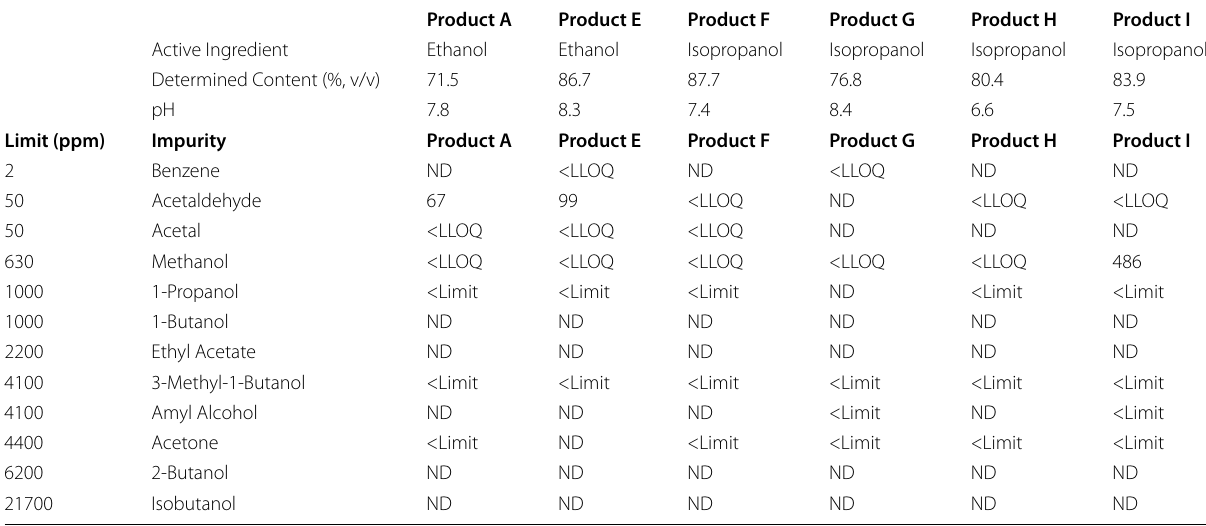
Acronyms in table: <LLOQ